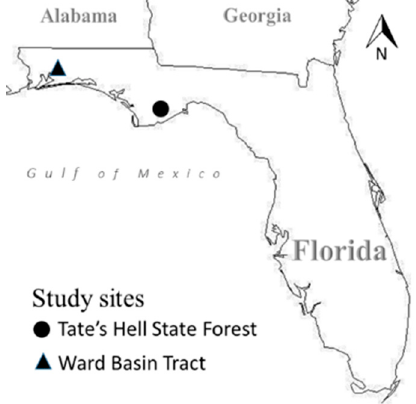
Figure 1. Location of study sites (Tate’s Hell State Forest and Ward Basin Tract) in northwest Florida, USA.